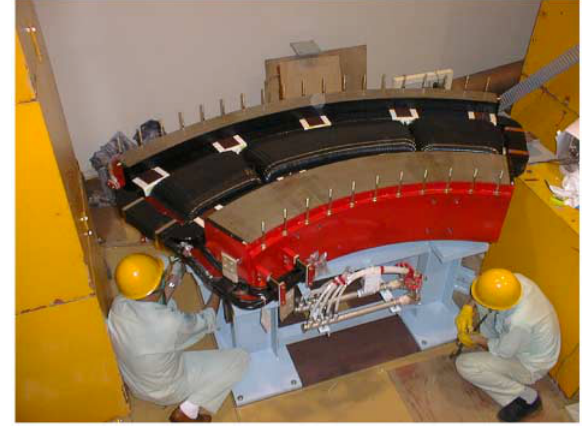
FIG. 8. (Color) Lower half of the model